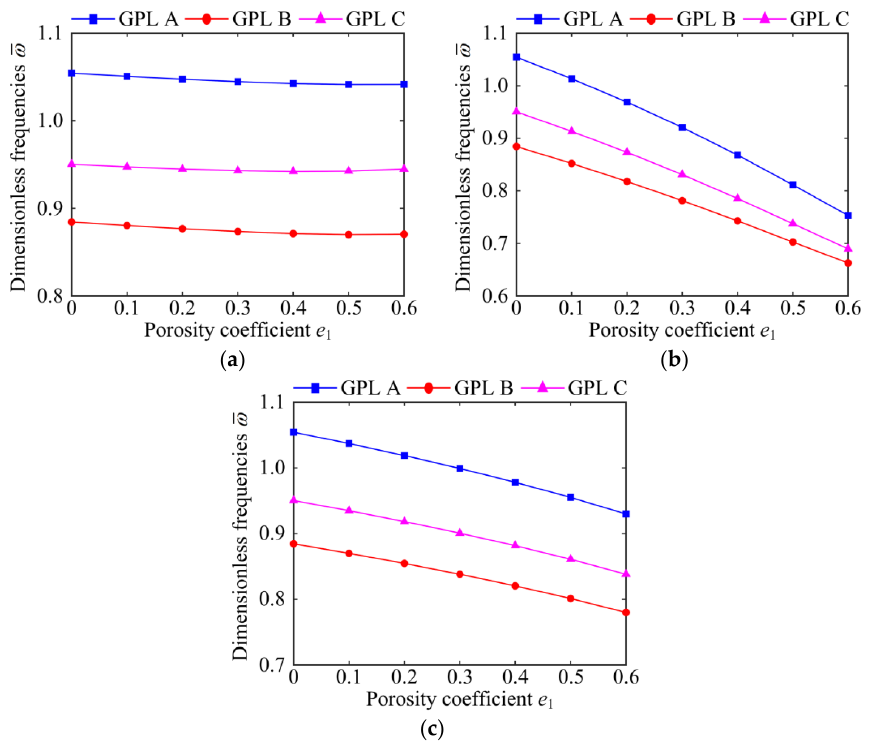
Figure 6. The influences of porosity coefficient on dimensionless fundamental frequencies of the GPLRP, two-cylindrical-panel system (CCCC). ( a ) Porosity-I; ( b ) Porosity-II; ( c )